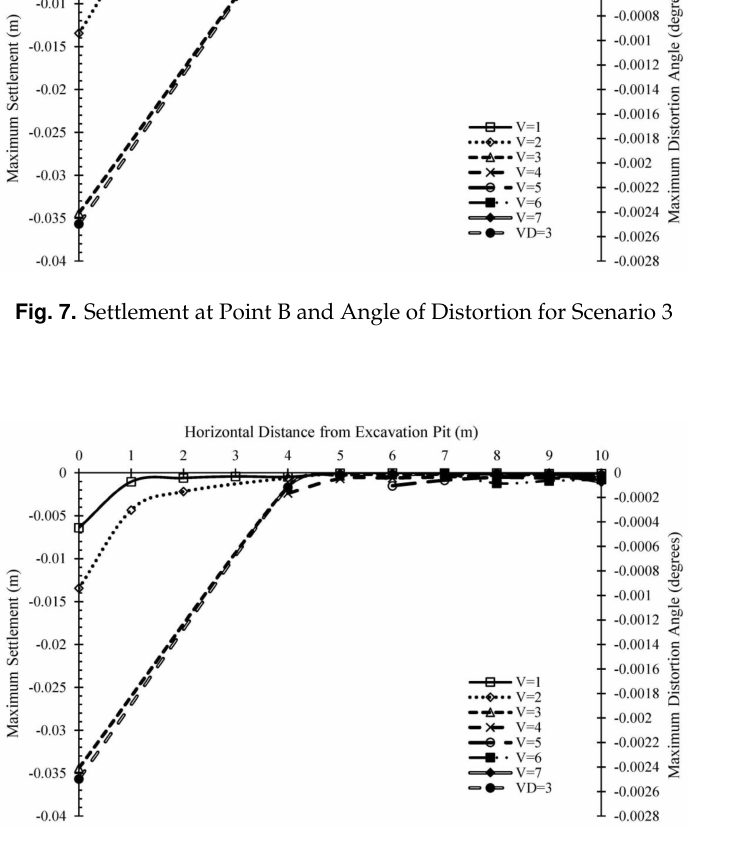
Fig. 8. Settlement at Point B and Angle of Distortion for Scenario